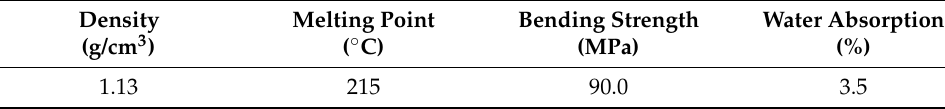
Table 1. The physical properties of the